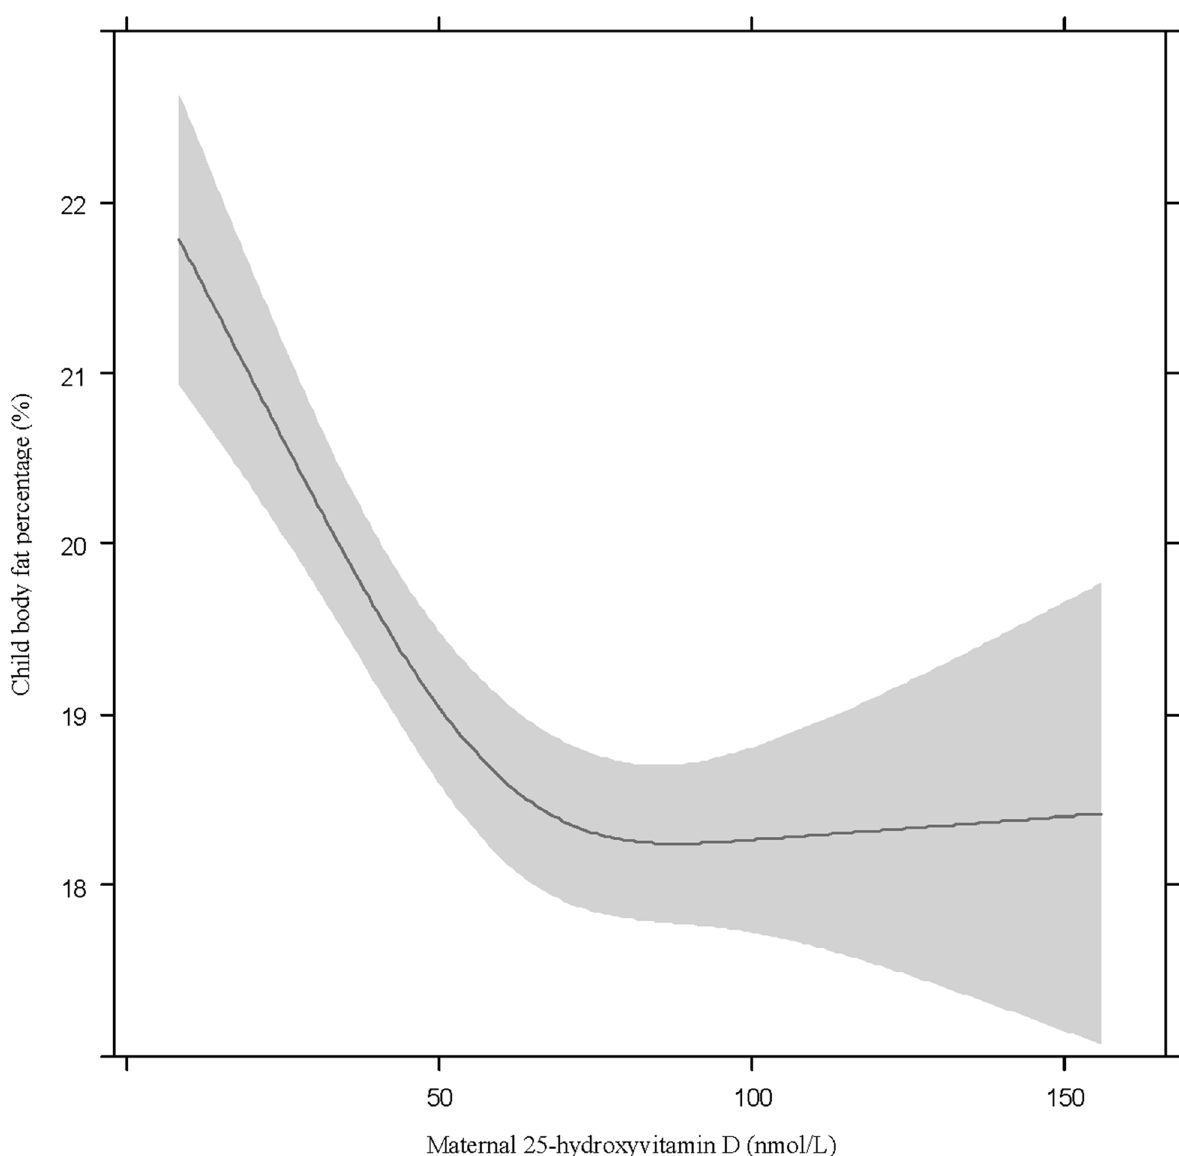
Fig 4. The association between maternal 25-hydroxyvitamin D concentration and percentage body fat in young children. The association between maternal 25-hydroxyvitamin D concentration and percentage body fat in 5 – 6 year old children, per model 1 (adjusted for child age (5.7 years) and presented for male